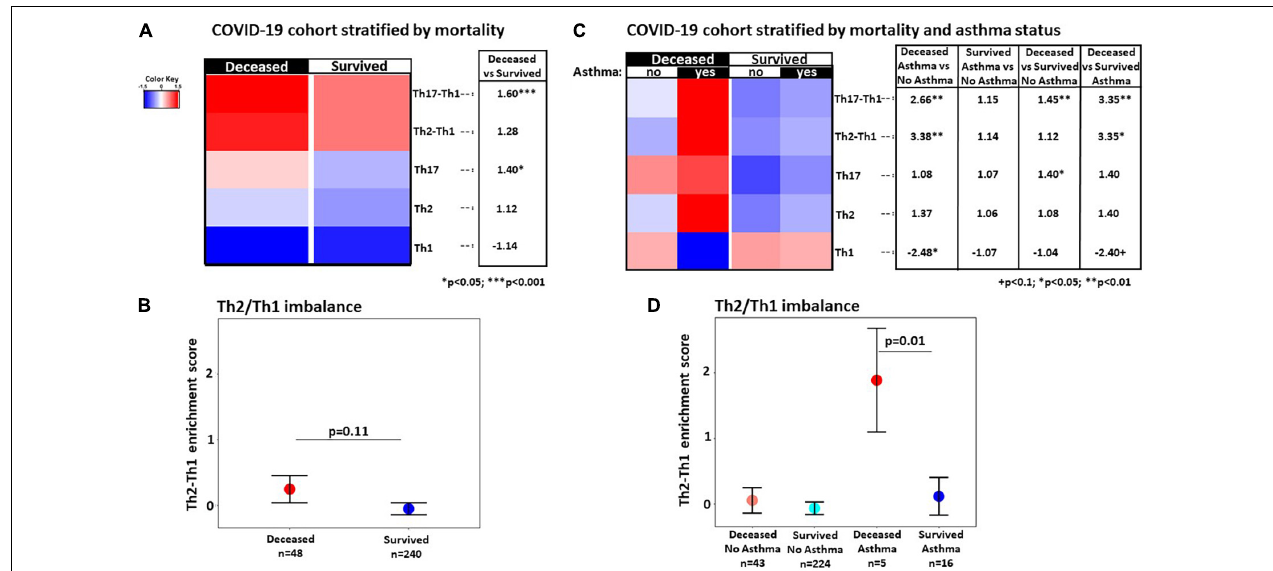
FIGURE 2 | (A) Heatmap of mean enrichment score by gene set variation analysis in all patients in the hospitalized COVID-19 cohort, stratified by subsequent mortality, with fold-change differences provided in the side table. (B) Mean difference in Th2 and Th1 enrichment scores in deceased versus survived patients. (C) Heatmap of mean enrichment scores by gene set variation analysis in asthma and non-asthma patients, stratified by mortality, with fold-changes provided in the side table. (D) Mean difference in Th2 and Th1 enrichment scores in deceased versus survived patients stratified by asthma status; means were estimated by a linear regression with age adjustment; + p < 0.1, * p < 0.05, ** p < 0.01, *** p <